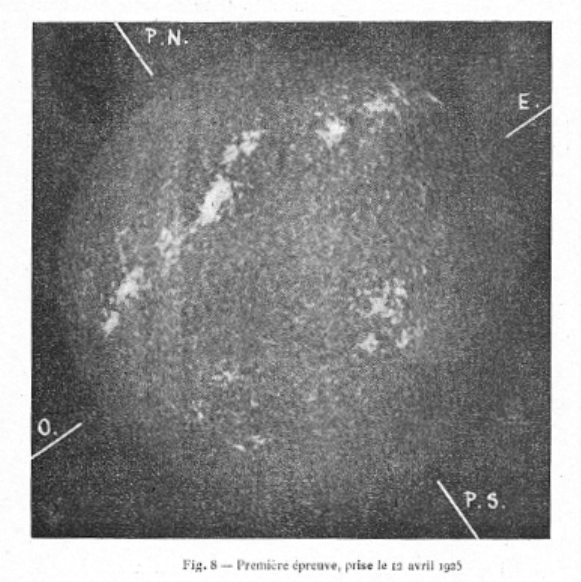
Figure 5. The first spectroheliogram acquired at the COI on April 12th, 1925 [Source: Lobo (1926)].